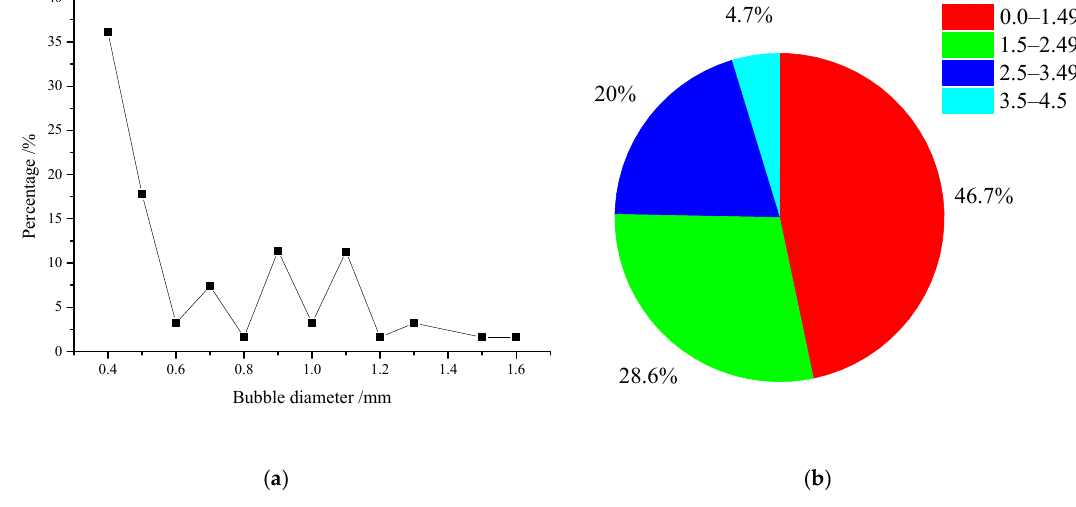
Figure 5. Bubble size distribution. ( a ) Bubble diameter distribution, ( b ) percentage of bubble size of each group.